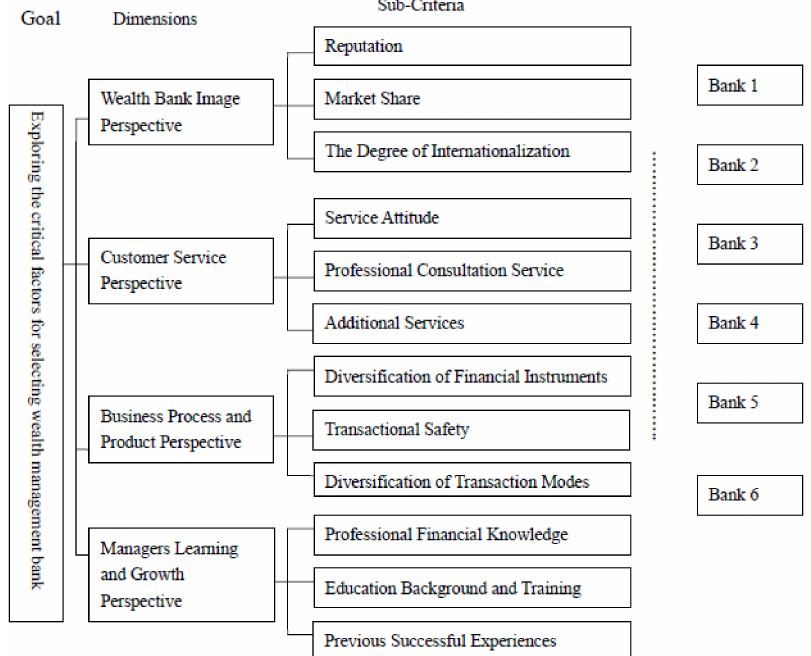
Figure 1. Wealth management bank evaluation